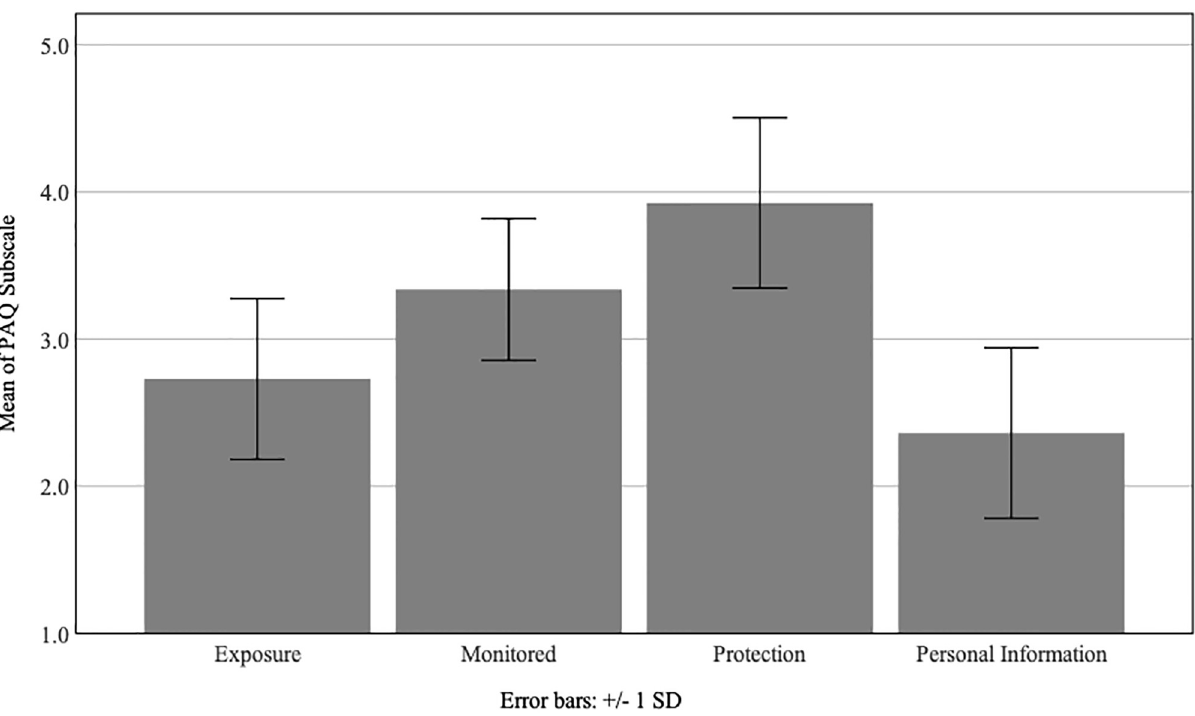
Fig 2. Responses from the privacy attitude uestionnaire for exposure (n = 9), monitoring (n = 9), protection (n = 8), and personal information (n = 10). A lower score indicates a higher level of privacy concern within each factor; error bars represent ± 1 standard